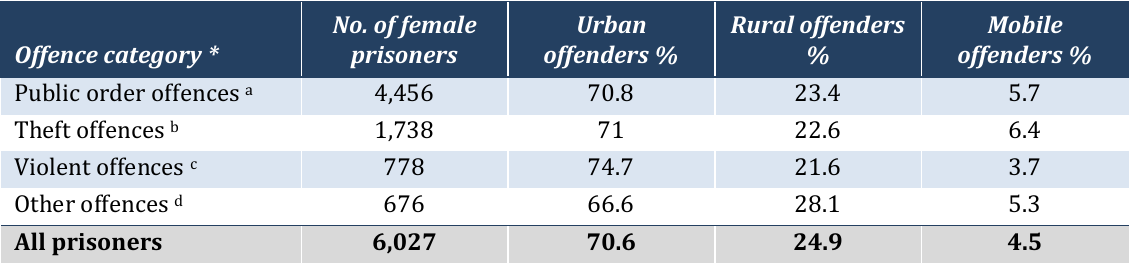
Table 3: Offence participation rates among female urban, rural and mobile offenders Offence category